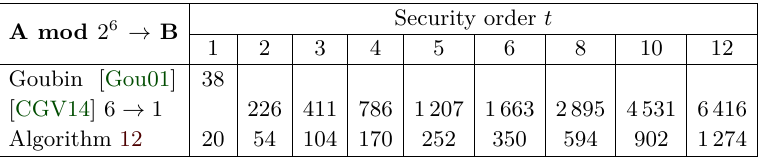
Table 7: Operation count for arithmetic modulo 2 k to 1-bit Boolean conversion algorithms, up to security order t = 12, with n = t + 1 shares and k =